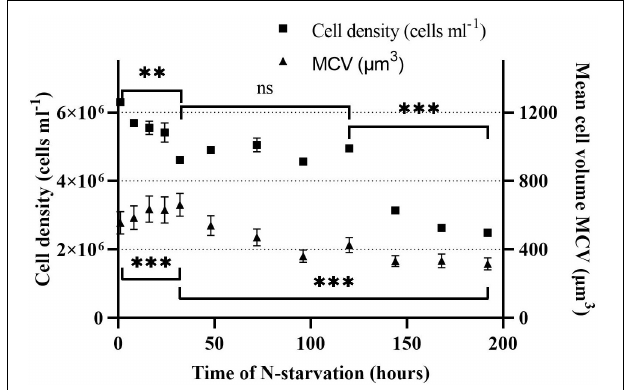
FIGURE 2 | Cell density and mean cell volume (MCV) of Rhodomonas sp. during a 192 h N-starvation period of time. Data are expressed as the average of three replicates ± SD. *Indicates the significant difference after ANOVA post hoc test. ns P > 0.05, ** P < 0.01, *** P < 0.001.